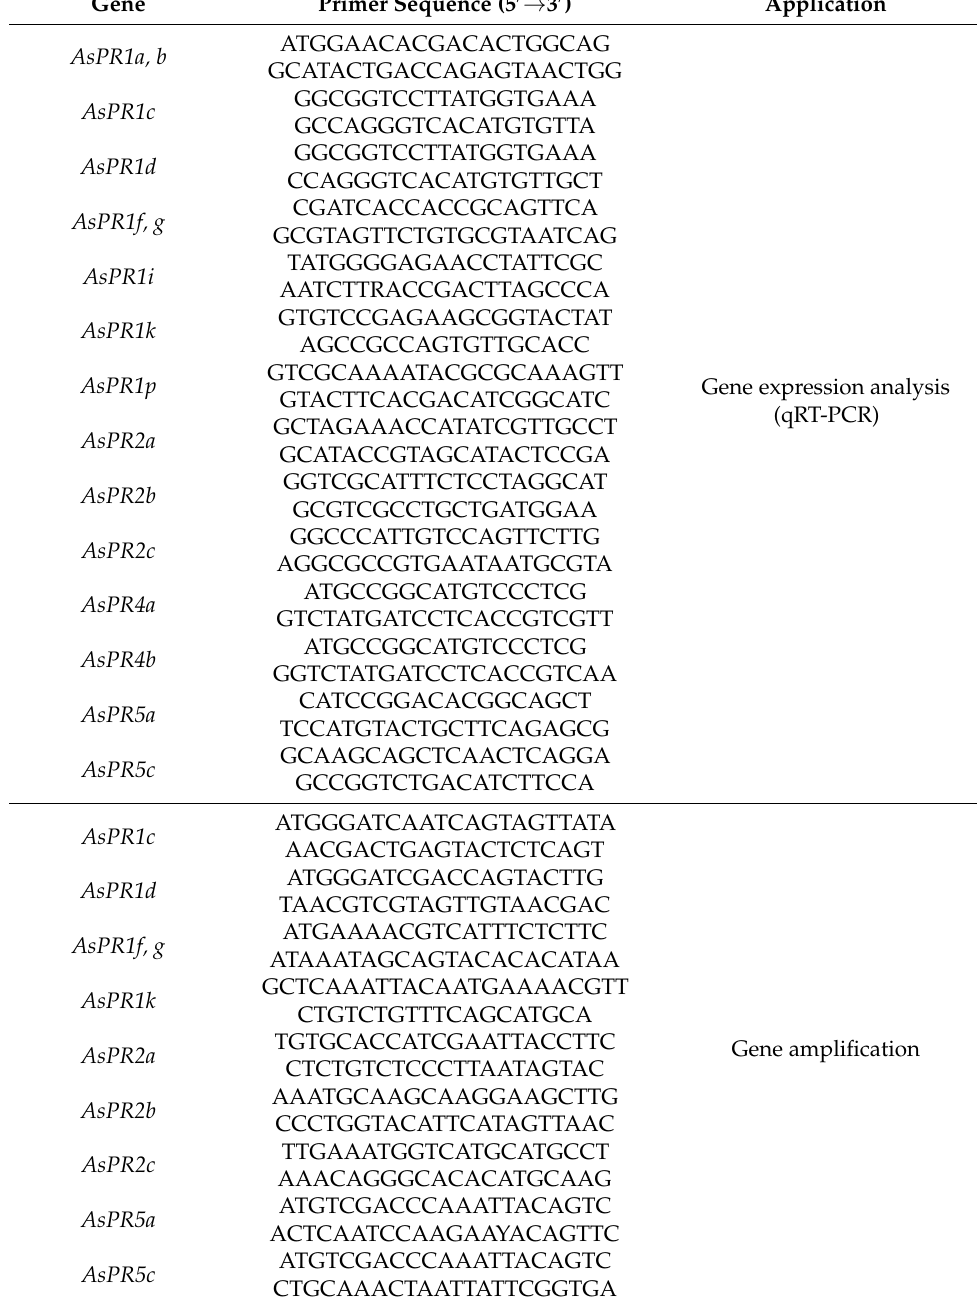
Table 5. The list of primers used in the study. Gene Primer Sequence (5 (cid:48) → 3 (cid:48) )